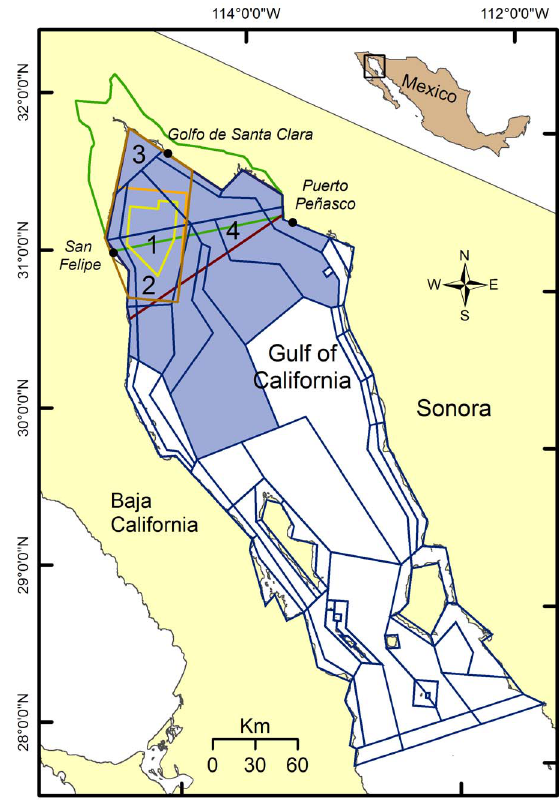
Figure 1. Northern Gulf of California Atlantis model extent, including Atlantis polygon geometry and polygons affected by management scenarios (blue shading). The main fishing commu- nities in the Upper Gulf are indicated. Simulated spatial management restrictions in the Upper Gulf (yellow to red lines), including the Upper Gulf Biosphere Reserve (green line). Numbers correspond to scenarios: 1) Vaquita refuge (1264 km 2 ), 2) Extended refuge (3579 km 2 ), 3) Primary area (5339 km 2 ) and 4) Distribution area (8432 km 2